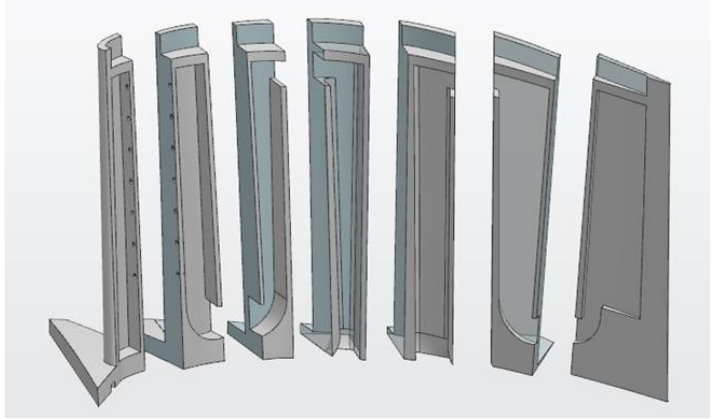
Figure 13. Adaptive longitudinal division results of the blade based on skeleton lines.